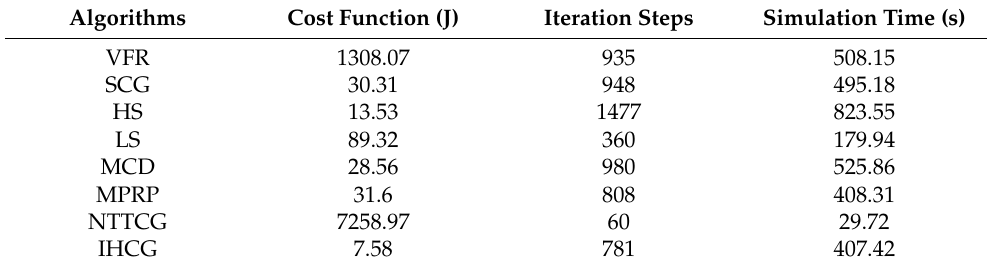
10 6 Comparison of convergence process J by different CG algorithms